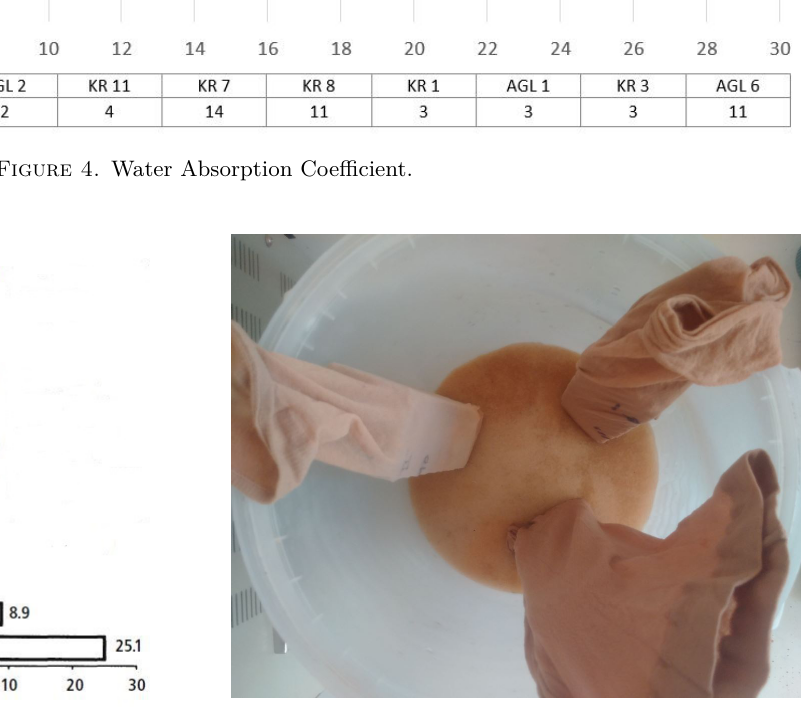
Figure 6. Specimens in nylon cover during